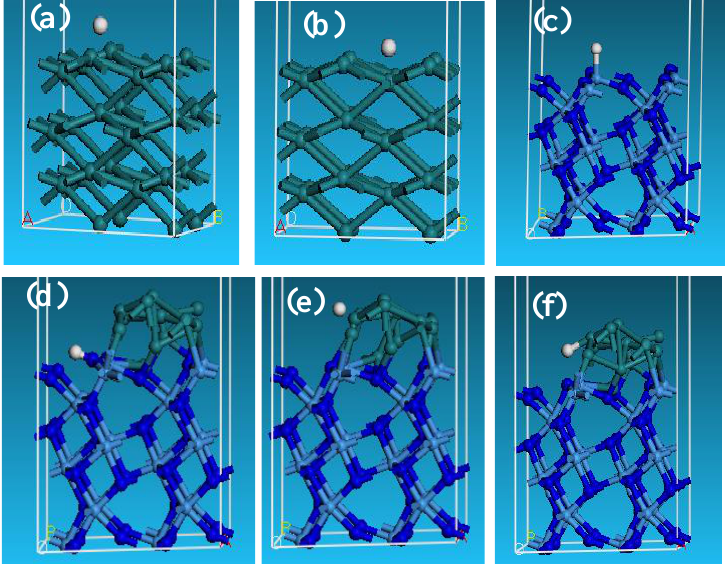
Figure 7. H atom absorbed on various crystalline structures: ( a ) Ru − H1; ( b ) Ru − H2; ( c ) Ta 3 N 5 − H; ( d ) Ta 3 N 5 − Ru − H1; ( e ) Ta 3 N 5 − Ru − H3; ( f ) Ta 3 N 5 − Ru − H4. (H: gray white; Ru: pale green; N: blue; Ta: light